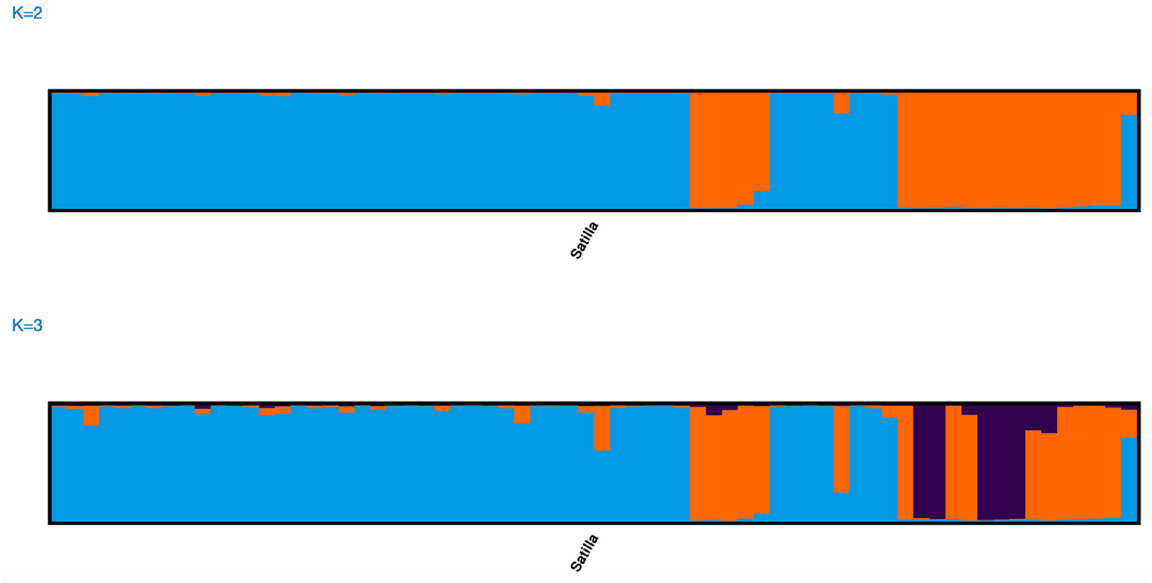
Figure 5. STRUCTURE analysis of the population structure of juvenile Atlantic sturgeon specimens from the Satilla River with K = two to three based on microsatellite analysis at 11 loci. Each vertical bar represents a single individual, and different colors represent the contribution of each K genetic cluster to each specimen’s genotype.